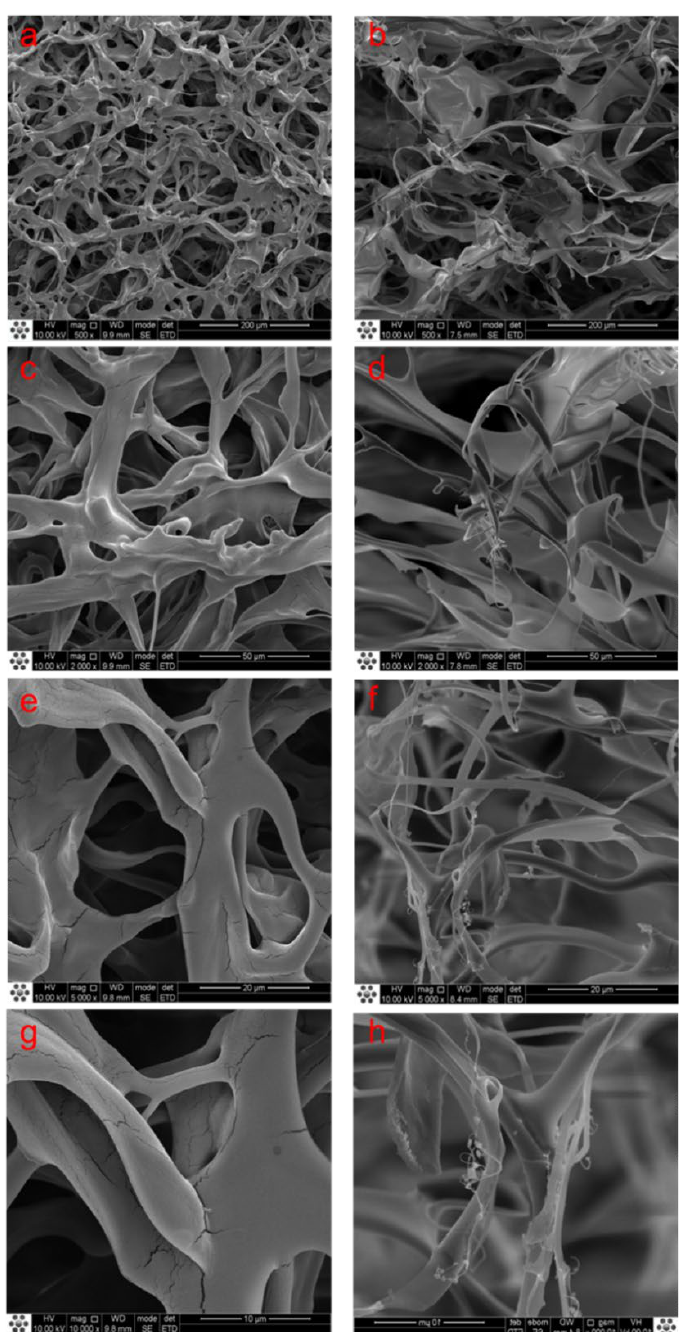
Figure 7. Scanning electron microscope images of CMC before ( a , c , e , g ) and after ( b , d , f , h ) modifica- tion.